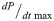
Diagram depicting the main signals and the VNS parameters analyzed in this paper.A) Representation of the left ventricular pressure signal (red), electrogram (EGM, green) and Vagus Nerve Stimulation signal (blue). B) Zoom displaying the main markers extracted from each beat: the inter-beat interval (RR interval) representing the chronotropic effect, the interval between the P-wave and the R-wave (PR inteval) used as a marker of the dromotropic effect and the maximum of the first of the Plv signal (dPdtmax). C) A typical VNS burst delivered synchronously with a cardiac beat (after a given delay Pdel), showing the VNS parameters studied in this paper.